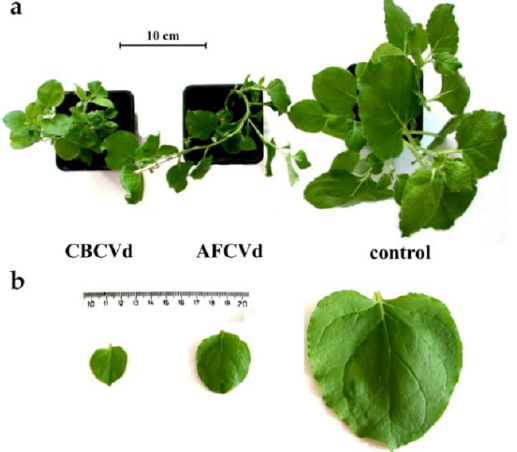
Figure 5. Growth characteristics of N. benthamiana transformed with CBCVd and AFCVd cDNAs under 35S promoter. ( a ) Overall plant habitus of CBCVd, AFCVd and control plants (view from above). ( b ) Size comparison of leaf blades of CBCVd, AFCVd and control plants. The fifth (expanded) leave counting from stem apex was collected from each variant.